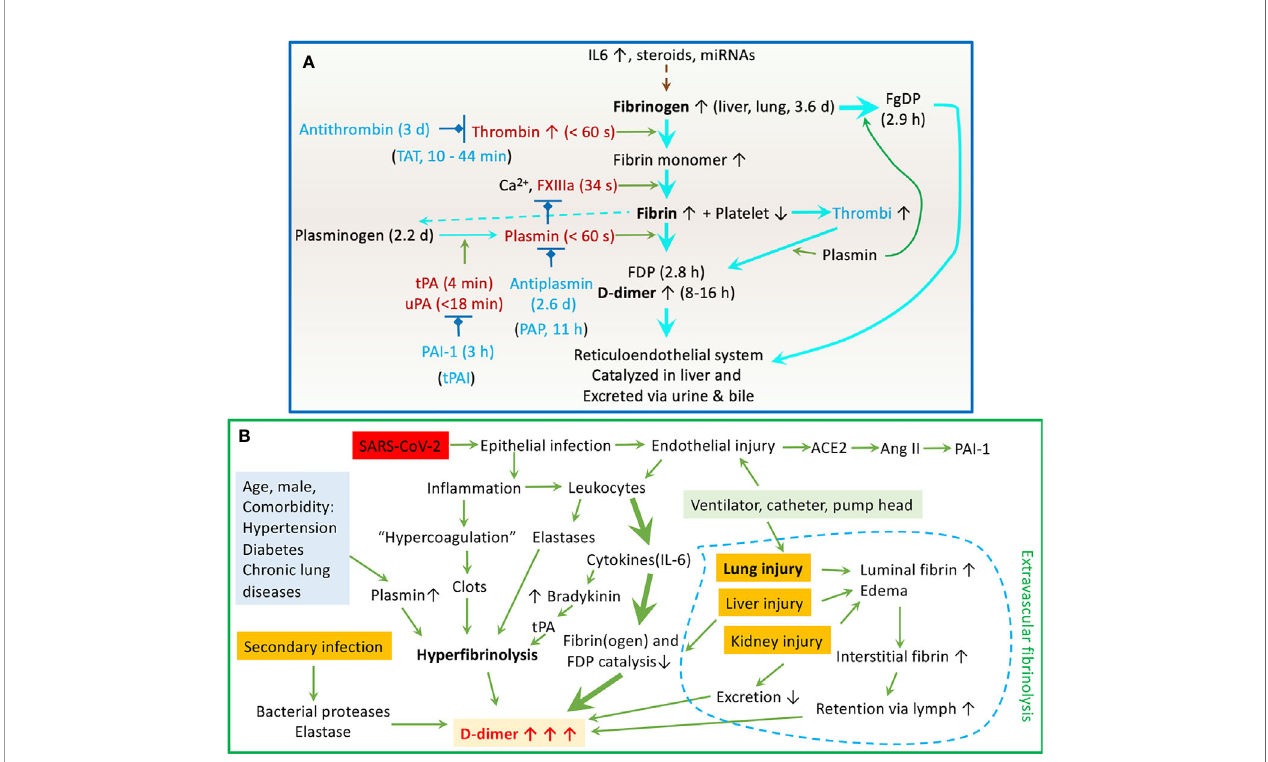
FIGURE 5 | Schematic mechanisms for the dynamic D-dimer level in COVID-19 patients. (A) Regulation of the fi brinolysis system. The half lifetime for crucial components is given in followed brackets. (B) Clinicopathological mechanisms for elevated plasma D-dimer in COVID-19